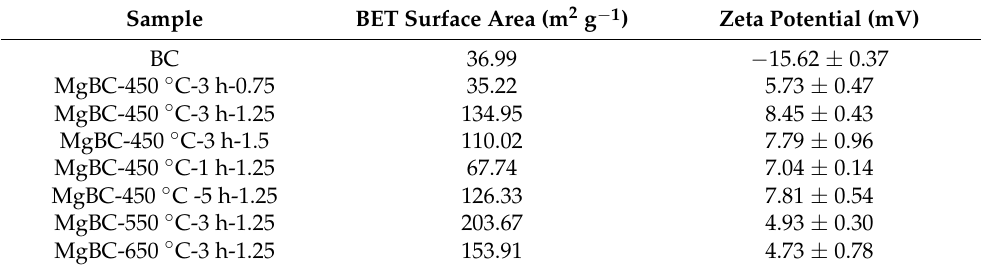
Table 1. BET and Zeta potentials of MgBCs with different preparation